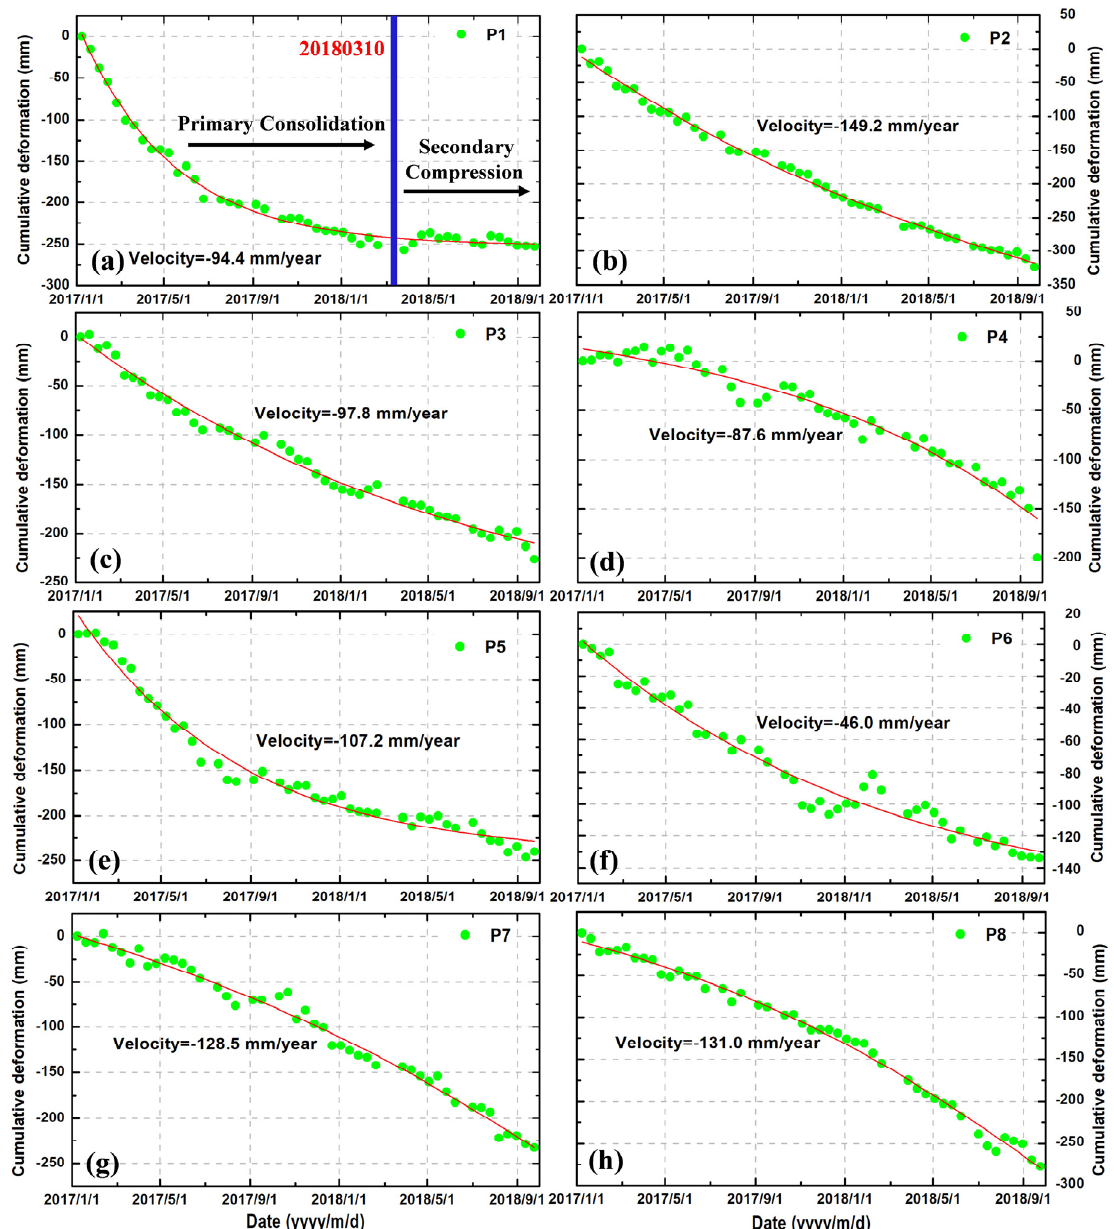
Figure 7. Time series deformation in the vertical direction of Xiamen New Airport from January 2017 to October 2018 for points P1 to P8. The locations of points P1 to P8 are shown in Figure 6. ( a ) Point P1; ( b ) point P2; ( c ) point P3; ( d ) point P4; ( e ) point P5; ( f ) point P6; ( g ) point P7; ( h ) point P8.